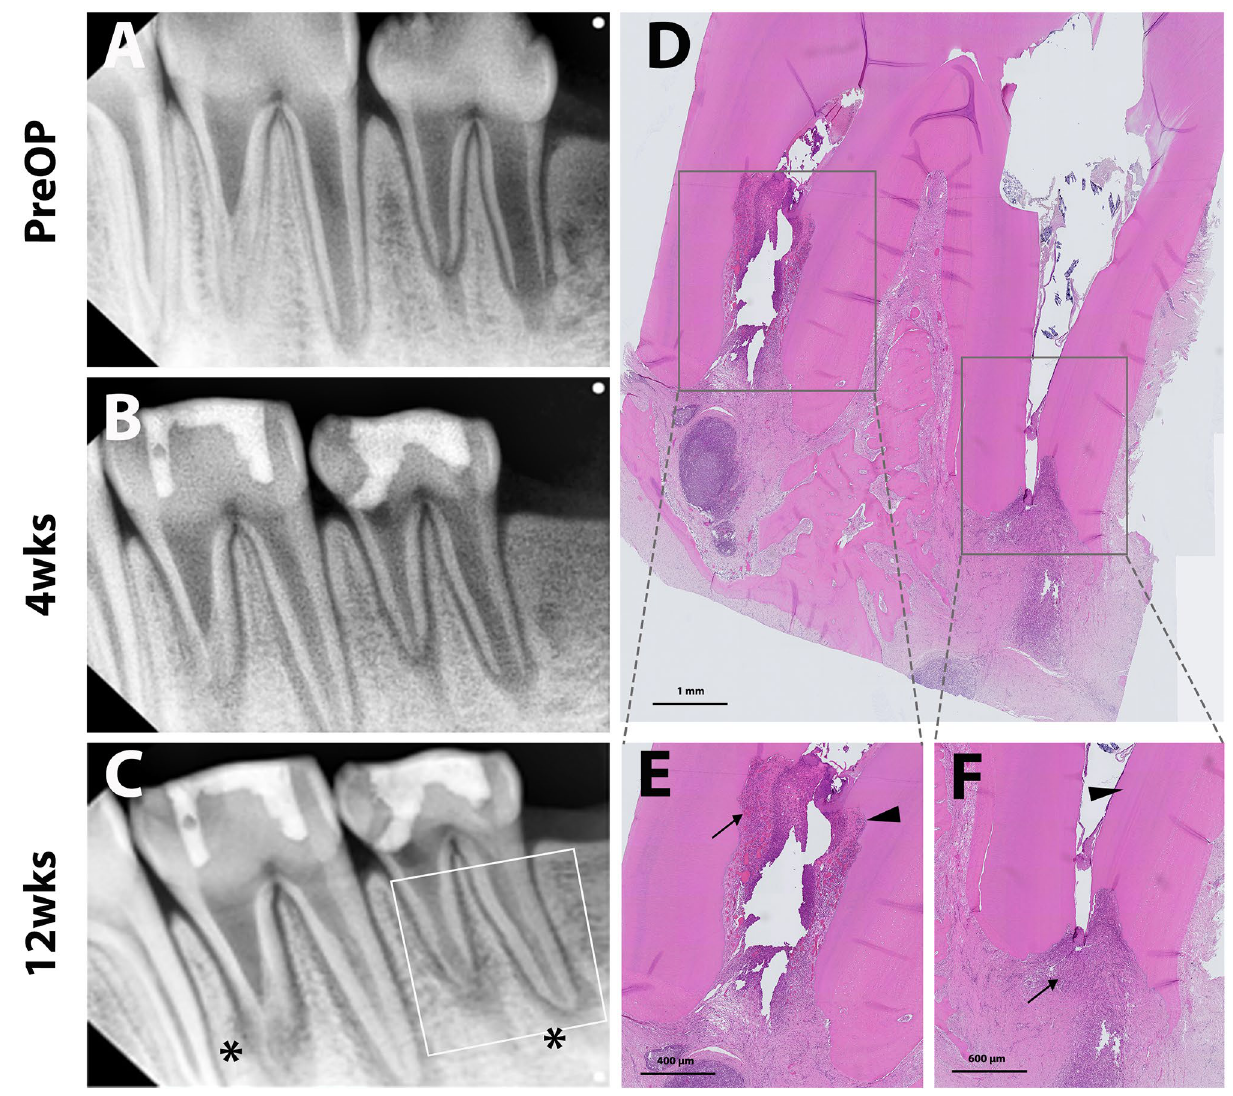
Figure 3. Representative radiographic and histologic images of the negative control (NC) group. Pulps were extirpated, and cavities were sealed directly with restorative glass ionomer cement. Periapical radiographs were taken preoperatively and at 4 and 12 weeks after treatment ( A , B , and C , respectively). Internal root resorptive lesions were observed, which implicates pulpal inflammation, continuing root thickening/lengthening, and apical narrowing (white line square, C ). Asterisks indicate the periapical radiolucency of the apices. After 12 weeks, the teeth were collected and processed for histologic analysis. Full images of the tooth showed periapical inflammation ( D ). Internal root resorption (arrowhead) with infiltration of inflammatory cells in the resorptive and periapical lesions (arrows) was observed ( E ). Newly-formed mineralized tissue deposition (arrowhead) in root dentin and inflammatory cell infiltration (arrow) in the apical area are shown ( F